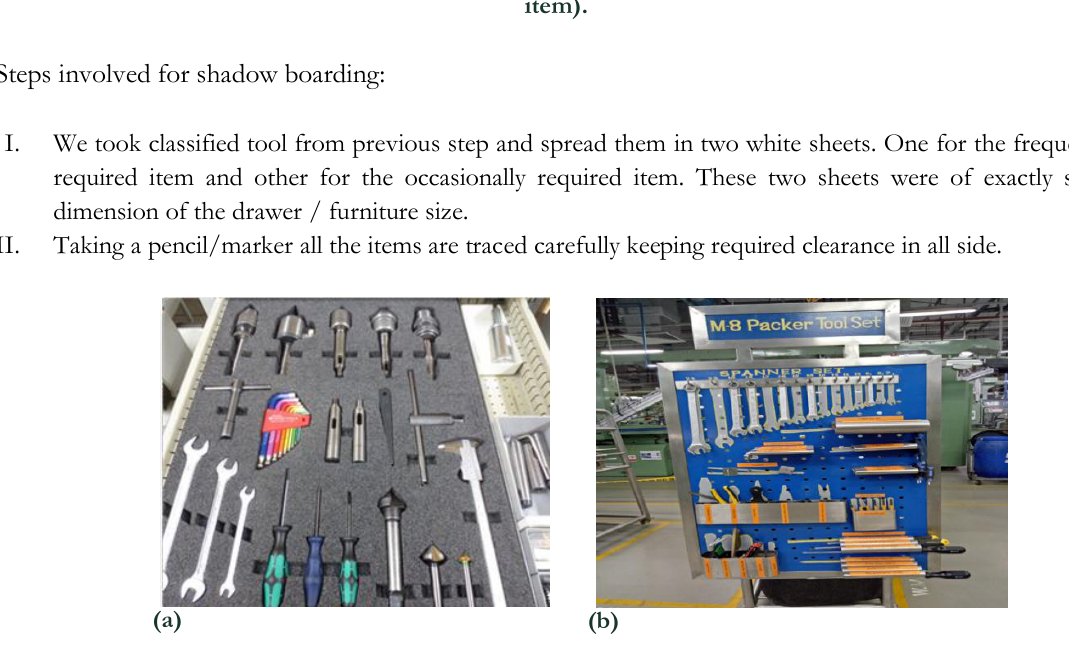
Figure 3. Implementation of shadow boarding concept in final design and construction of the tool set (Vertical and